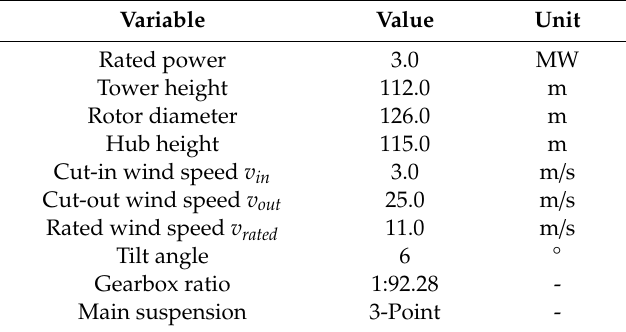
Table 1. C3 × 126 turbine parameters